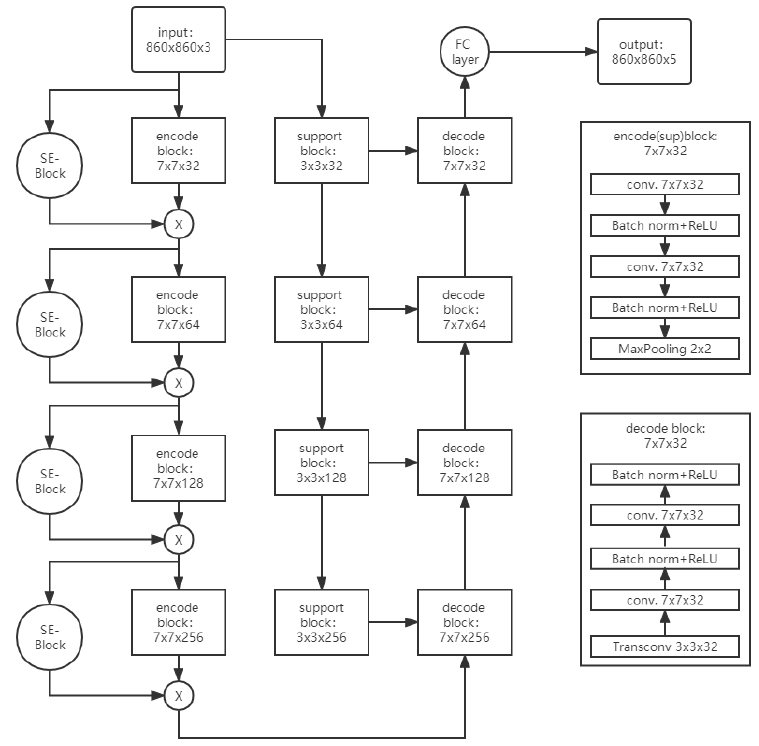
Figure 4. The structure of our